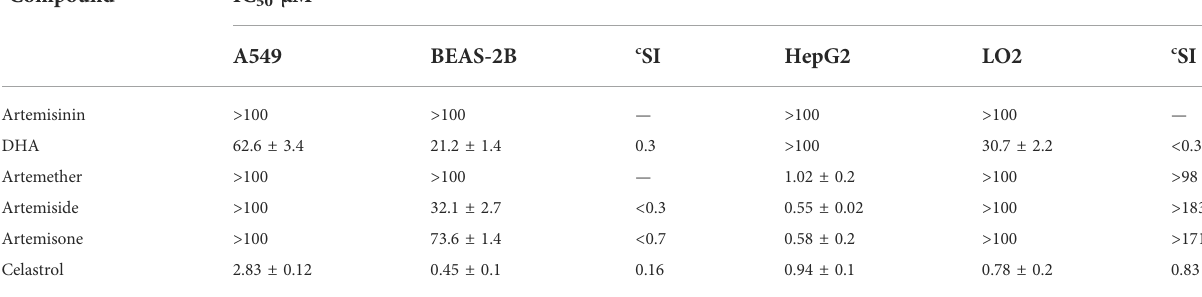
TABLE 4 Cytotoxicities of artemisinins and celastrol (µM) against tumour and non-proliferating cell lines in vitro .